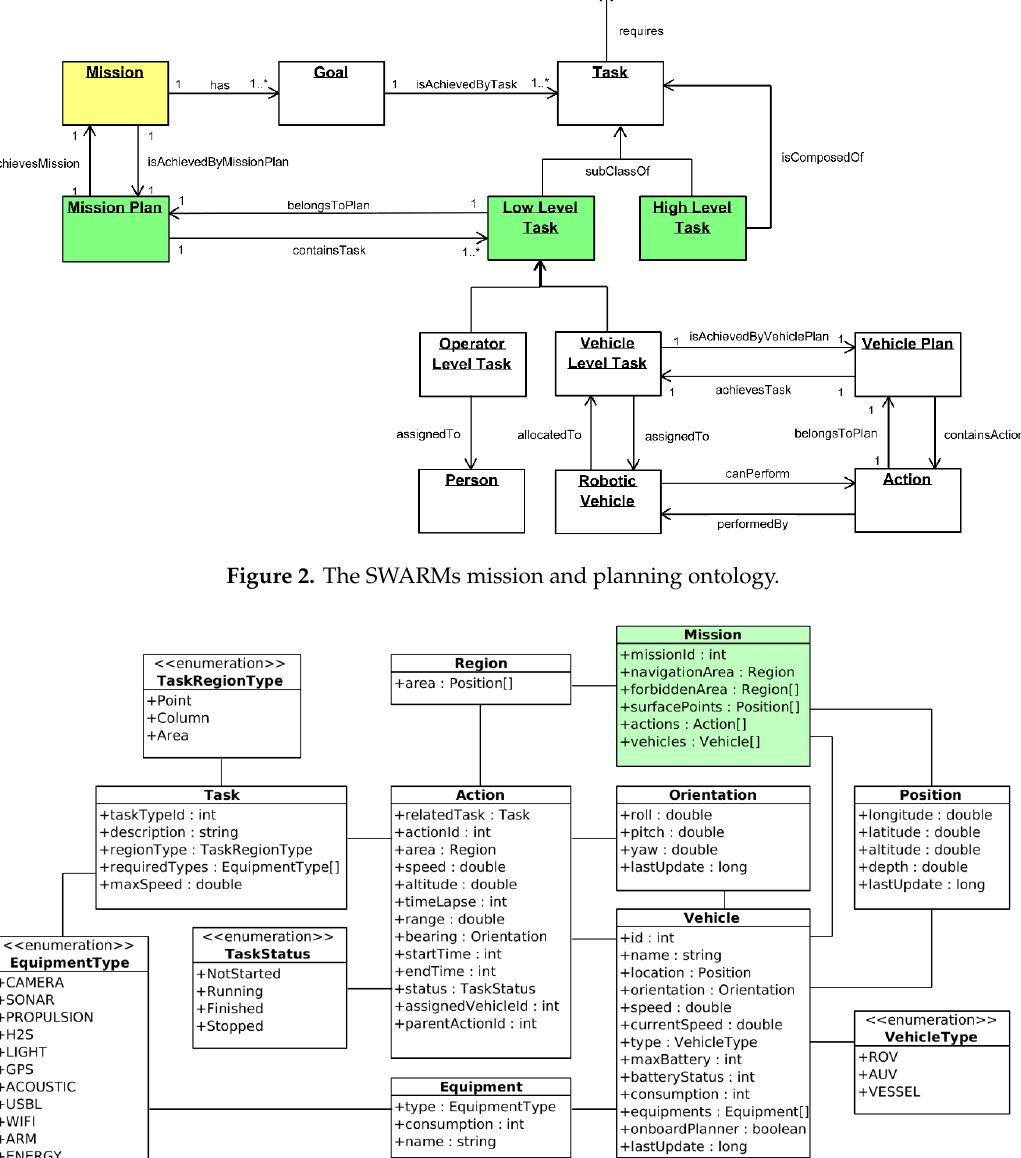
Figure 3. Structure of a SWARMs mission plan.